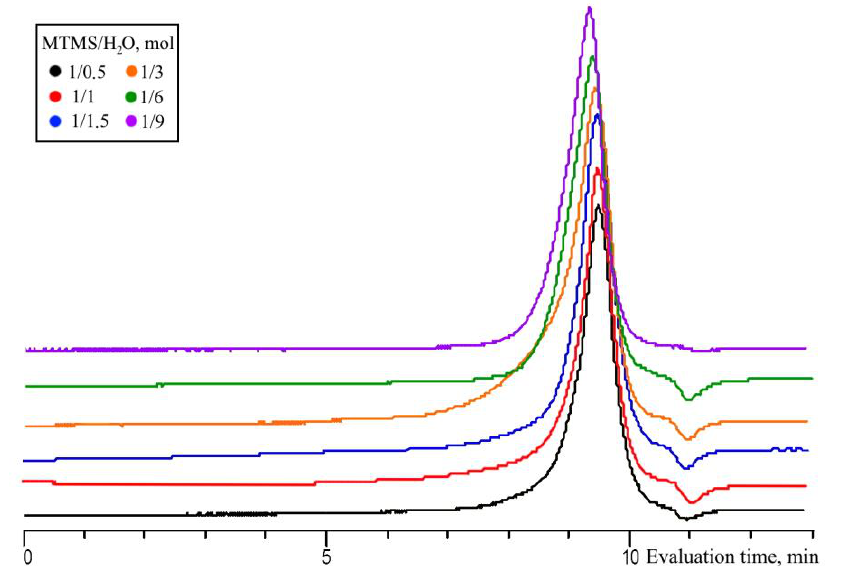
Figure 8. GPC curves for the oligomeric fraction by MTMS MWHP at different ratios of reagents and at 30 °C, 20 W for 90 min (Sample 1 – 6, Table 1).